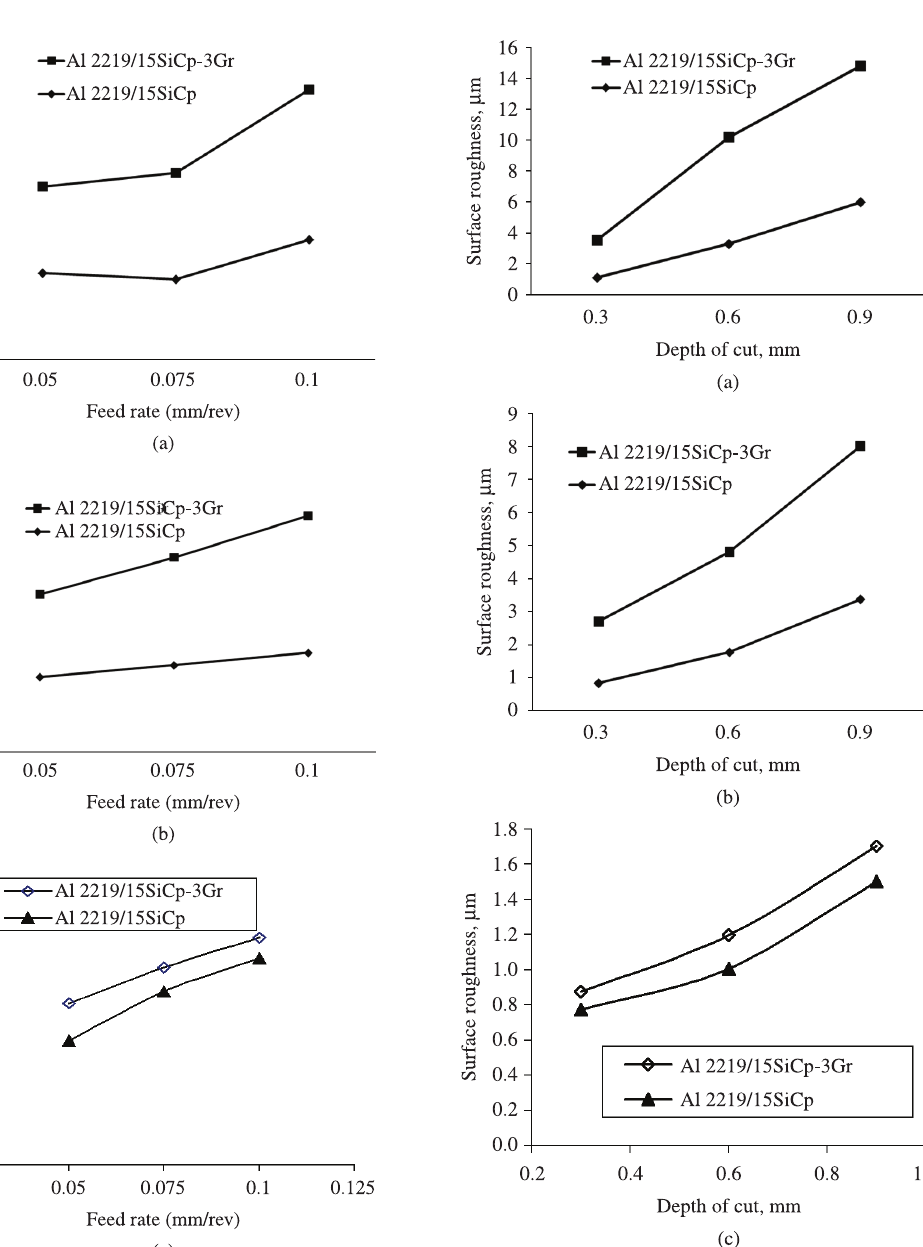
Figure 3 shows the variation in surface roughness values with the increase in depth of cut for all cutting conditions. As depth of cut increases, the cutting forces and surface deformation increases which leads to increase in surface roughness values. When the depth of cut is tripled, the surface roughness value increases two times in the case of SiCp reinforced composites and three times in case of graphitic composites.